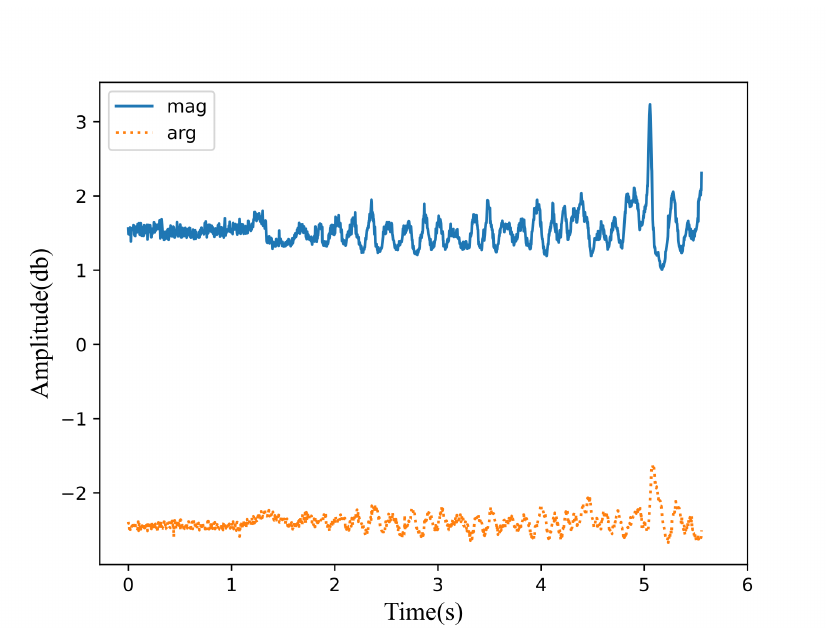
Figure 6. The data waveform after averaging the filtered signals of amplitude and phase.